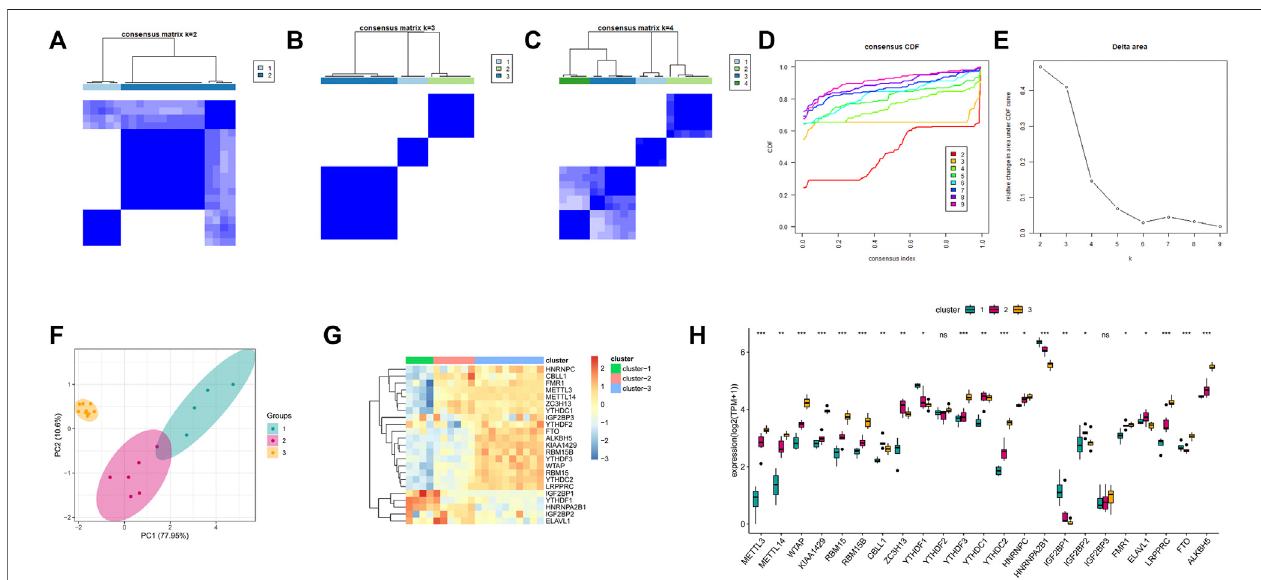
FIGURE 7 | Unsupervised clustering of 23 m6A regulators. Three distinct isoforms of m6A modi fi cation patterns were identi fi ed in OA. (A – C) Heat map of the co- occurrence ratio matrix of OA samples when k = 2 – 4. (D) Consensus clustering cumulative distribution function when k = 2 – 7. (E) Relative area under the CDF curve when k = 2-7 Changes. (F) Principal component analysis of the transcriptome pro fi les of the 3 m6A isoforms showed that the transcriptomes of different modi fi cation patterns were signi fi cantly different. (G) Unsupervised aggregation of 23 m6A regulators in the 3 modi fi cation patterns Class. (H) Expression status of 23 m6A regulons in 3 m6A isoforms.